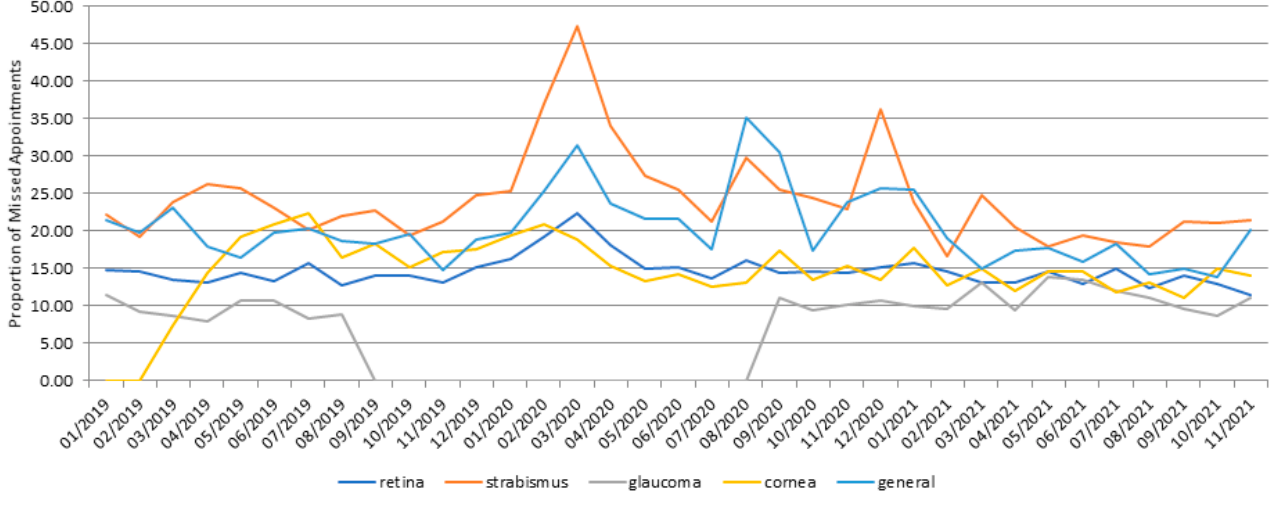
Figure 2. Monthly cancellation rates among different Ophthalmic Departments.